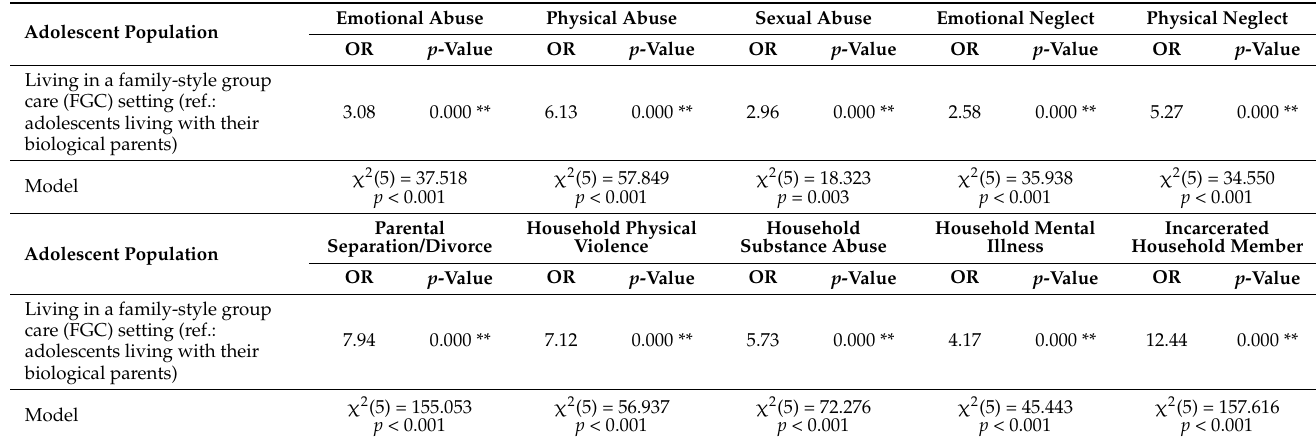
Table 5. Odds ratios for experiencing different types of ACEs for adolescents living in a family-style group care (FGC) setting compared to adolescents living with their biological